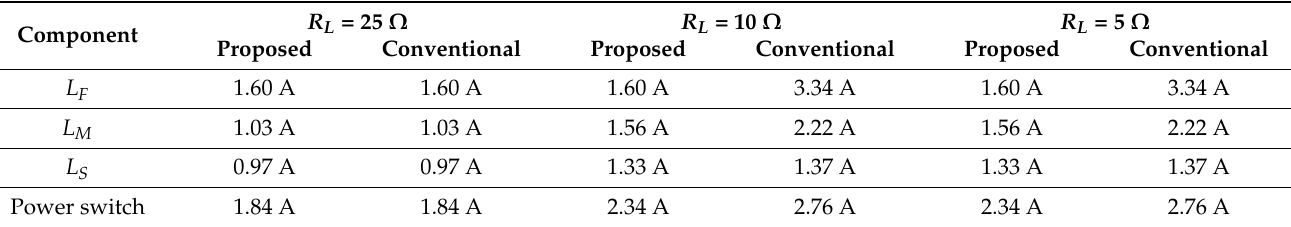
Table 3. RMS values of branch currents.